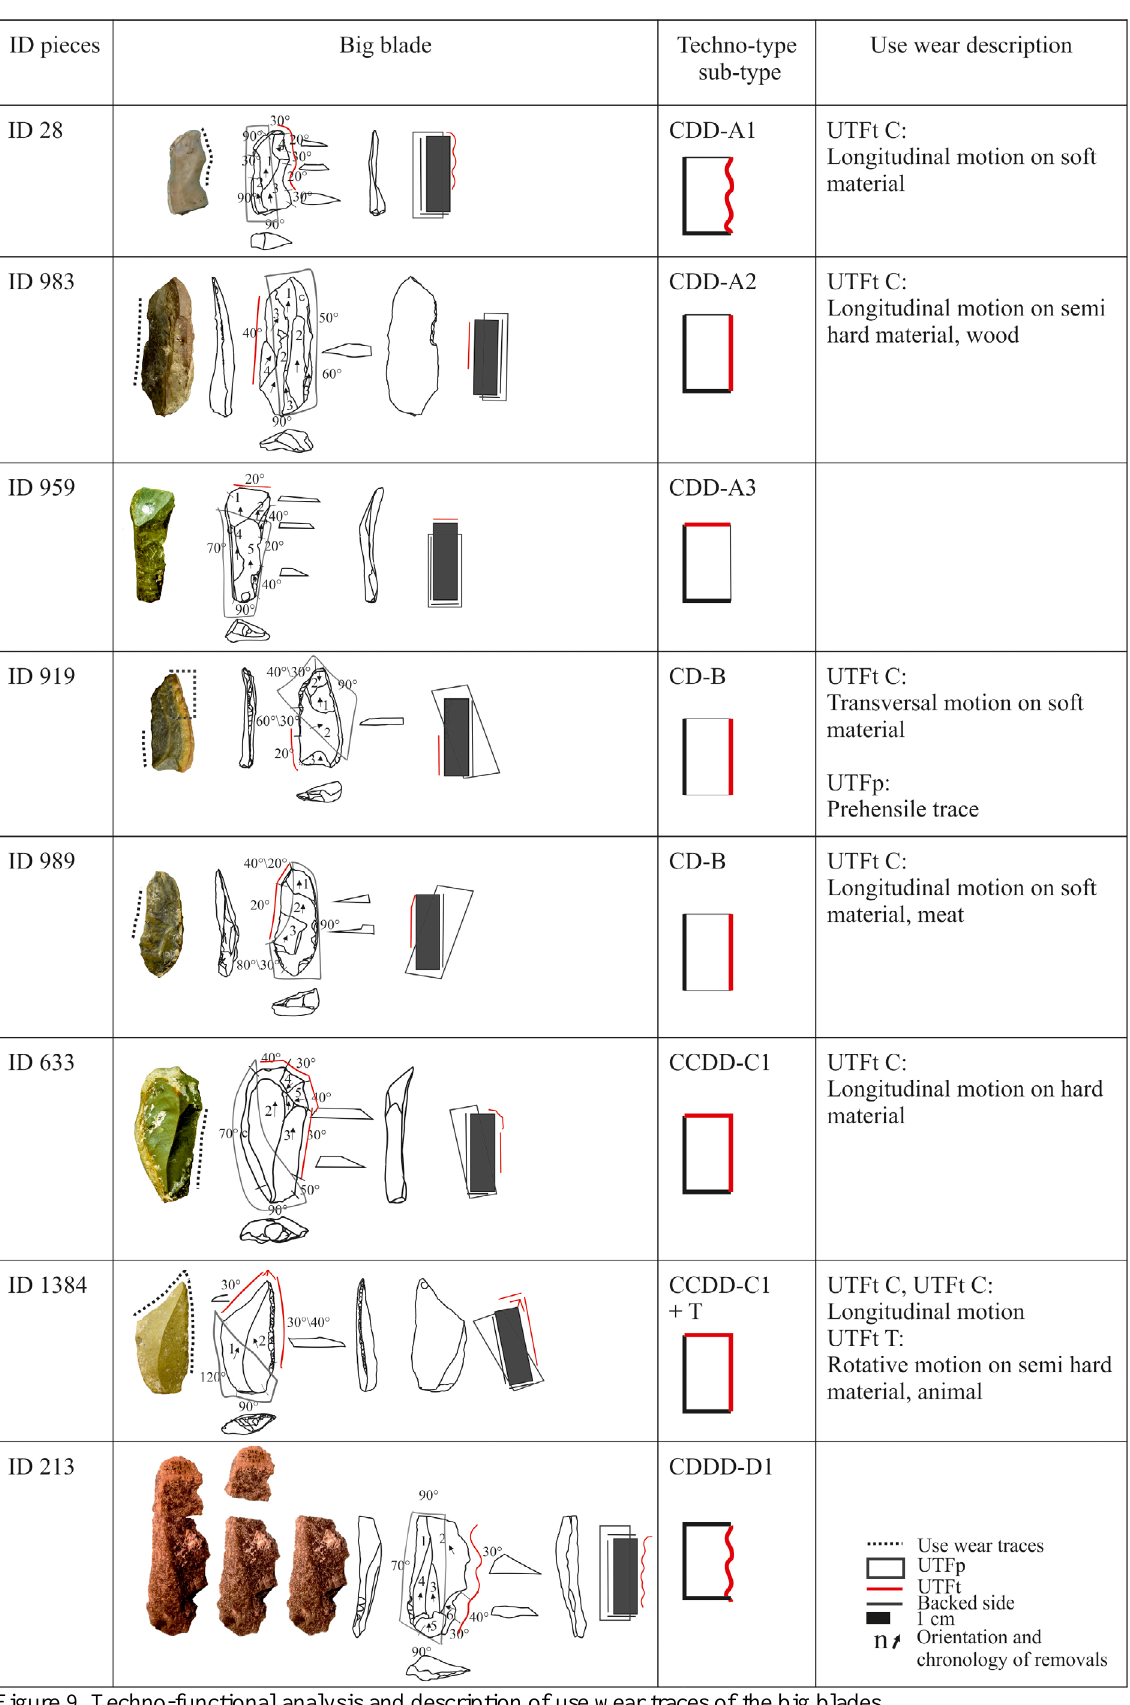
Figure 9. Techno-functional analysis and description of use wear traces of the big